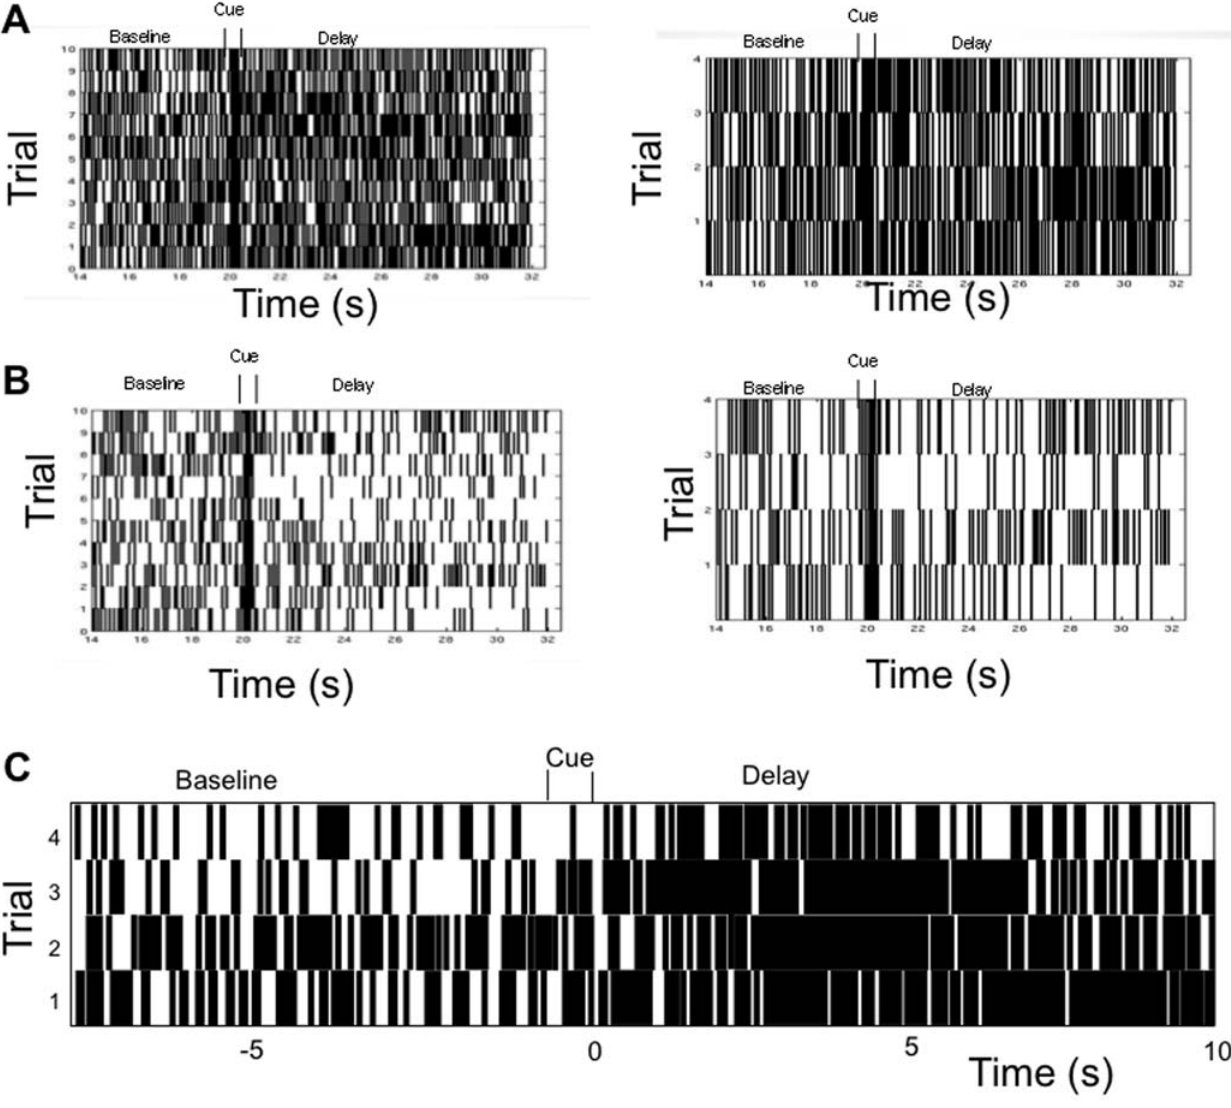
Figure 10. Raster plots of 10 trials (left) for an excitatory (A) and an inhibitory (B) unit from the 4-population 2000 unit spiking network. Note that different pattern types occur on different trials. Figures A and B (right) show an expanded version of 4 of the 10 trials from both units to highlight different patterns exhibited. From top to bottom of the expanded trials, the excitatory unit shows a decaying rate, nonresponsive, increasing rate, and persistent stable firing rate pattern, and the inhibitory unit shows decaying inhibition, stable inhibition, increasing rate excitation, and increasing inhibition. C) Rasters from 4 trials selected from a real neuron recorded from the prefrontal cortex during presentation of the same memorandum of the cross-modal task exhibiting stable persistent activation during the delay in the average PSTH. Although the cells exhibits stable persistent activation on average, on specific trials the cell exhibits the decaying rate activation pattern.